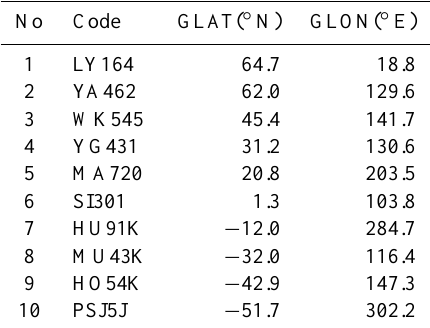
Table 1. Geographical coordinates of the stations labeled in Fig.